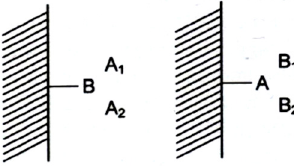
Figure 2 . The reciprocal supramolecular recognition principle. If the selector B separates the selectands A 1 and A 2 , than the selector A is expected to separate the selectands B 1 and B 2 . A i and B i are homologous compounds, congeners or isomers (including enantiomers).